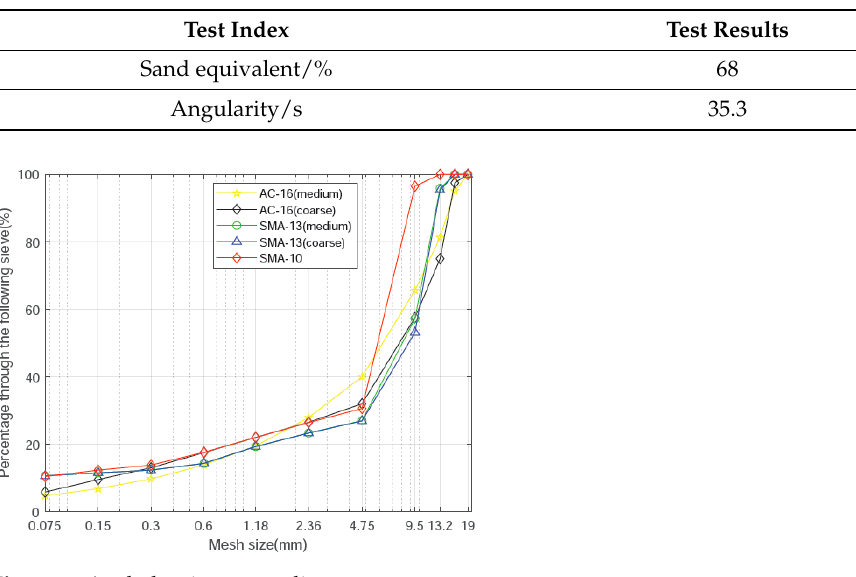
Figure 3. Asphalt mixture grading. Table 2. Coarse aggregate technical index test results.